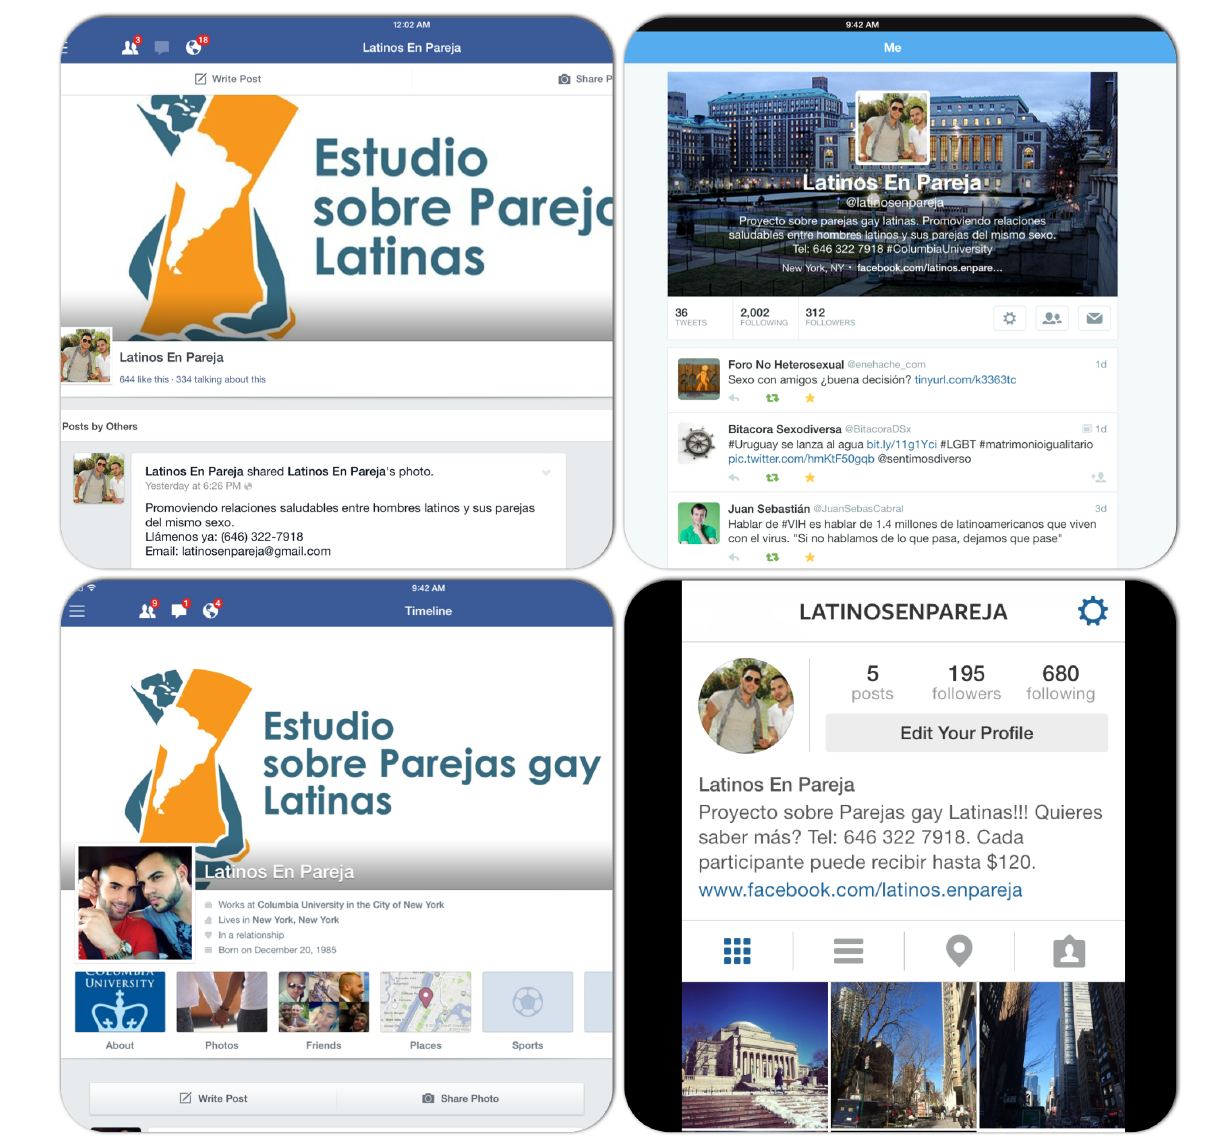
Figure 2. Collection of photos from our online social media